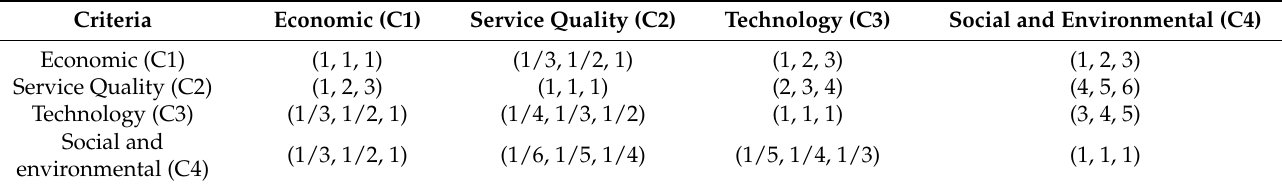
Table 5. The aggregated fuzzy comparison matrix of FAHP